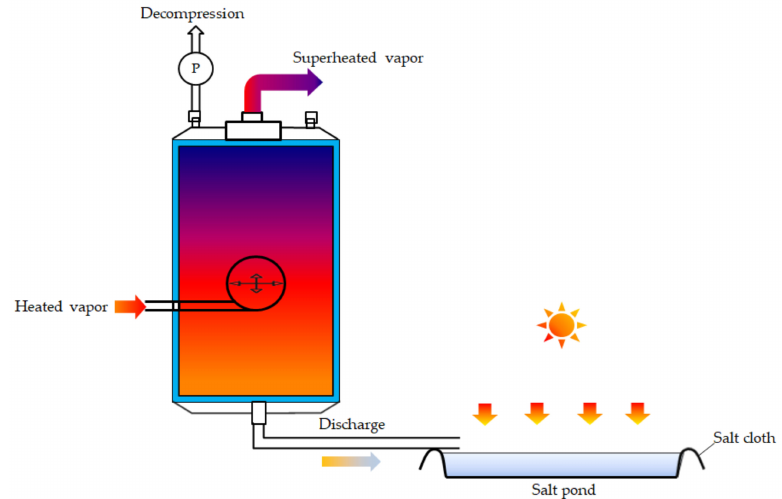
Figure 4. Structure diagram of the evaporator and salt